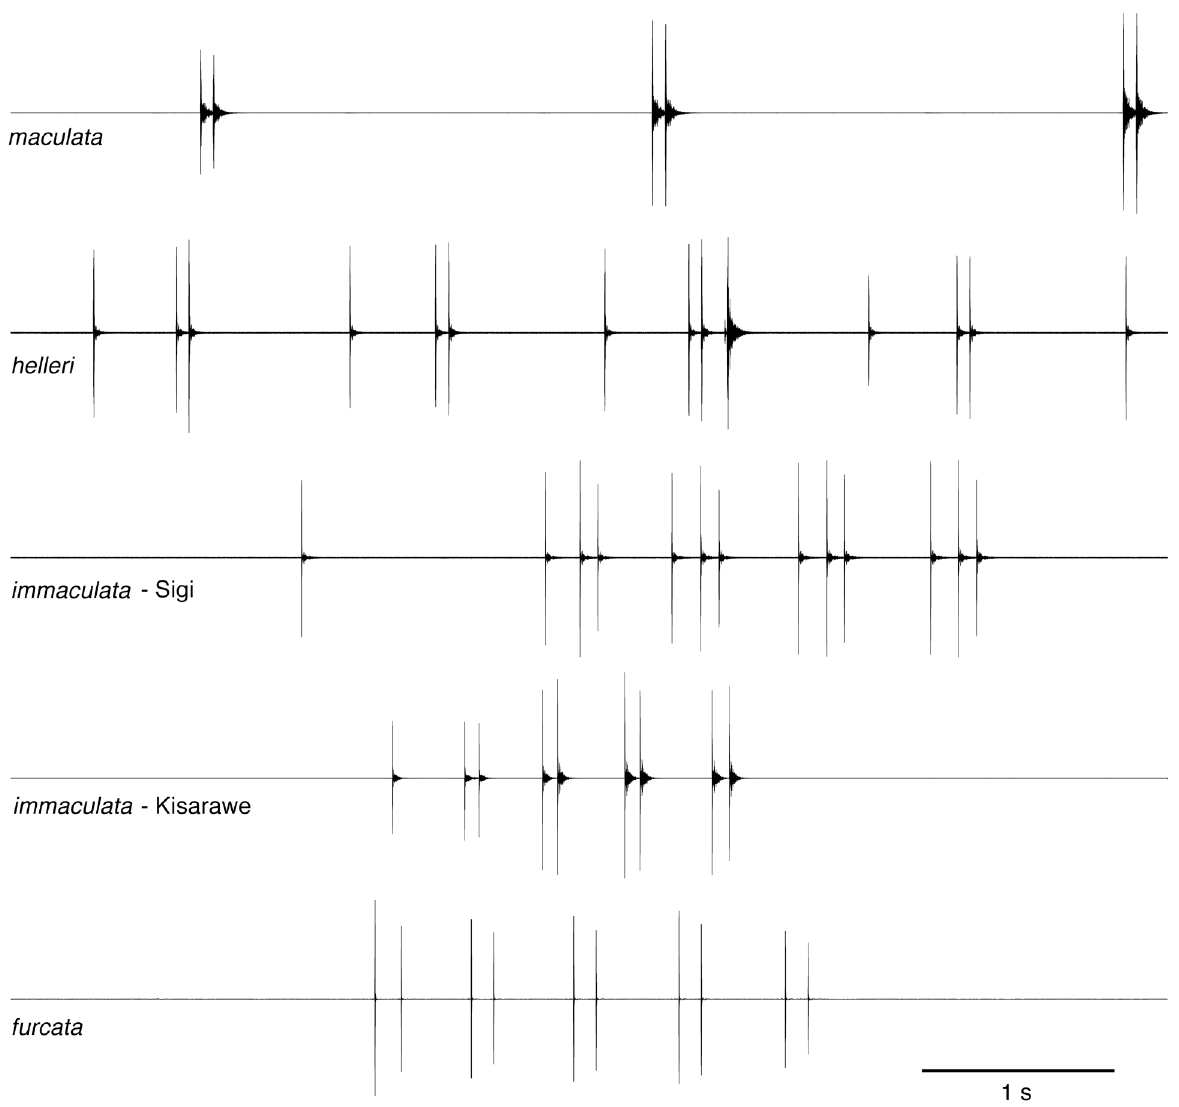
Figure 21. Oscillograms of the male calling song of Gonatoxia species. In G. maculata and G. helleri only part of a much longer sequence is shown, in G. immaculata and G. furcata complete